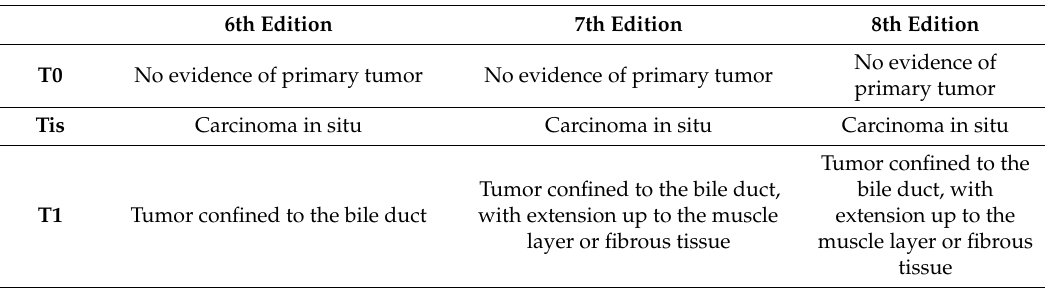
Table 1. American Joint Committee on Cancer (AJCC) staging system by tumor-node-metastasis (TNM) stage of the 6th, 7th, and 8th